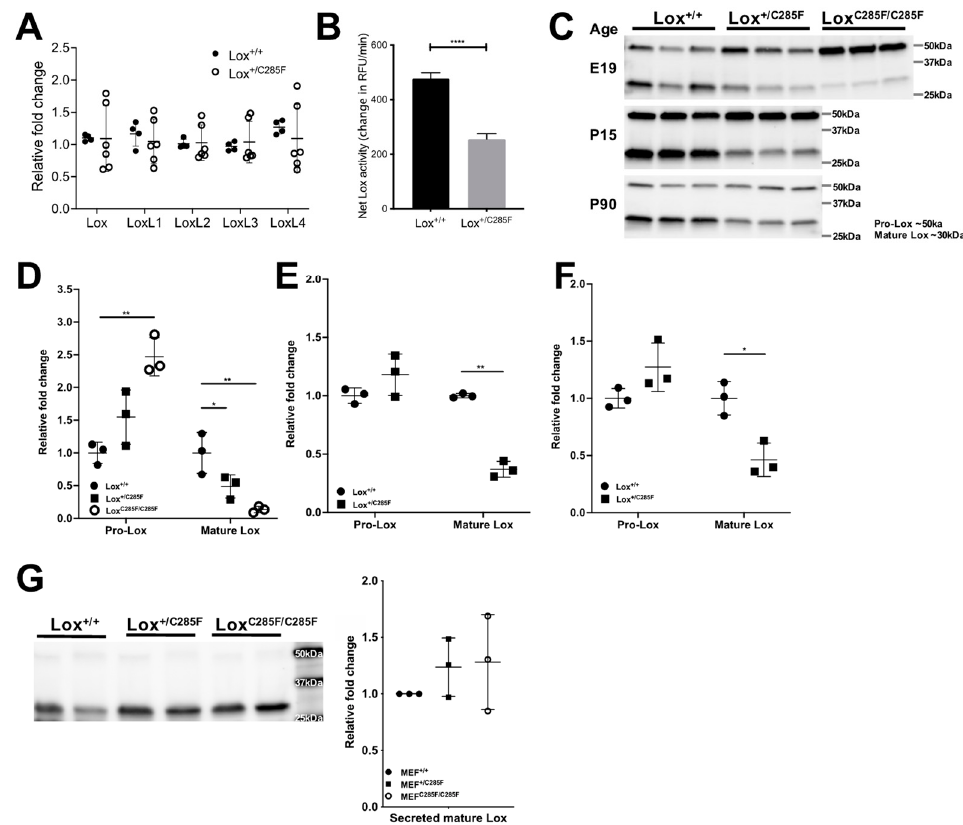
Figure 7. Mutation of Lox at C285F did not cause reduction in gene expression and Lox protein secretion as well as enzyme activity. ( A ), Lox and LoxL family members had similar mRNA expression in both Lox +/C285F and Lox +/+ mice as measured by quantitative PCR ( t -test). ( B ), Lox +/C285F aorta showed 46% reduction in Lox enzyme activity in Lox +/285F mice as measured by Amplex Red ( t -test; n = 8). **** p < 0.0001. ( C ), Total lysate from frozen aortas at age E19, P15, and P90 demonstrated higher quantities of 50 kDa proLox in Lox C285F/C285F as compared to Lox +/+ at age E19 only. However, a decreased amount of 30 kDa mature Lox in Lox C285F/C285F and/or Lox +/C285F was found in all three age groups. Graphs show the quantification of proLox and mature Lox at age ( D ), E19, ( E ), P15 and ( F ), P90 across all samples using total protein as normalization (( D ) one-way ANOVA ( p < 0.01 in both comparisons), Dunnet comparisons shown in figure; ( E – F ) Paired t -test). * p < 0.05; ** p < 0.01. ( G ) In conditioned medium collected from MEF isolated from Lox wild-type and mutant mice ( n = 3), comparable amount of secreted mature Lox protein was detected. (Right panel, one-way ANOVA, Dunn).